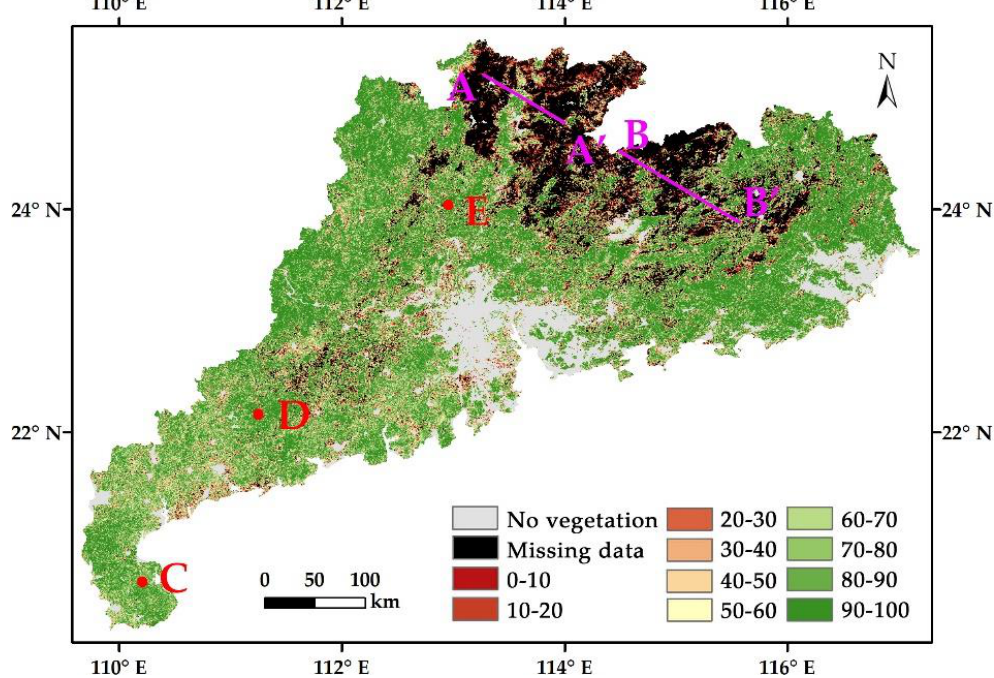
Figure 8. VCI of the 36th period of 2016 and the position of section lines and sample points. Line AA’ starts from A and ends at A’, with a total length of about 87 km. Line BB’ starts from B and ends at B’, with a total length of about 116 km. Point C, D and E are selected from land of agriculture, forest and forest grass mixed types, respectively.